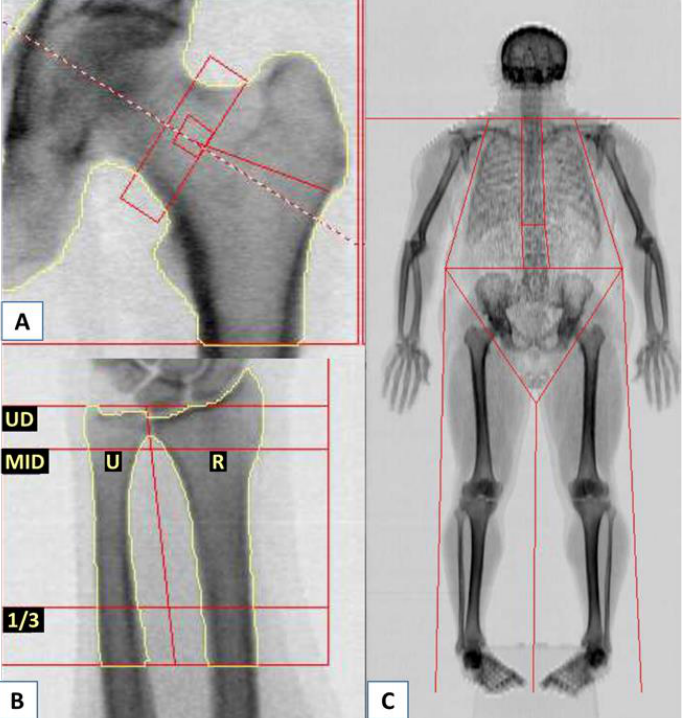
Figure 4. DXA scans of the left femoral neck ( A ), forearm ( B ), and total body ( C ). Abbreviations: 1/3, distal cortical part of 1/3 radius + ulna; MID, midshaft radius + ulna; R, radius; U, ulna; UD, ultradistal radius + Table 2. Lumbar spine bone density (DXA), TBS results and BMD results. A. Lumbar Spine BMD Results Assessed by DXA.